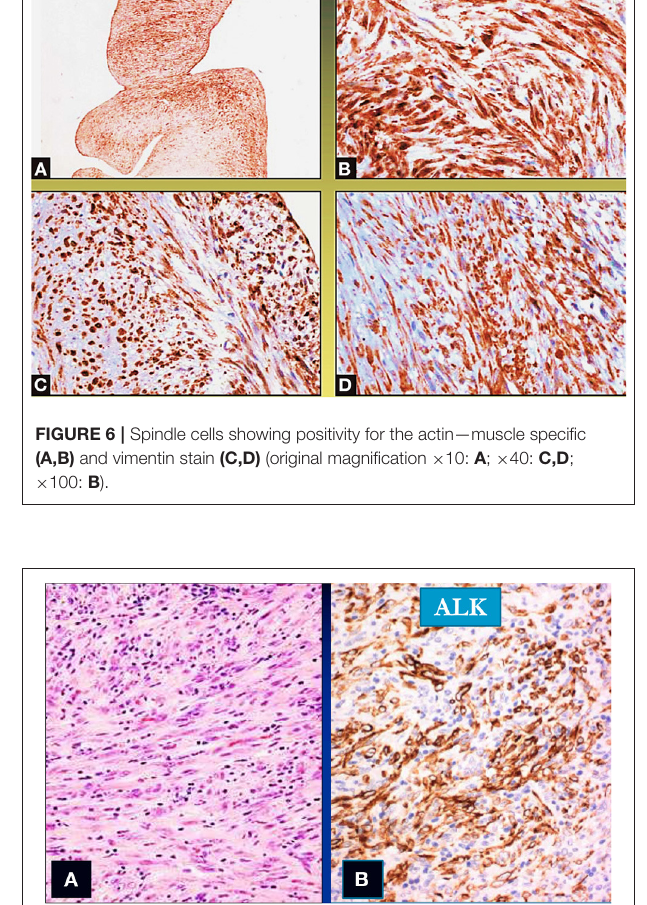
FIGURE 7 | Spindle cells (col Hem-Eos: A ) showing positivity for the ALK stain (B) (original magnification × 10).